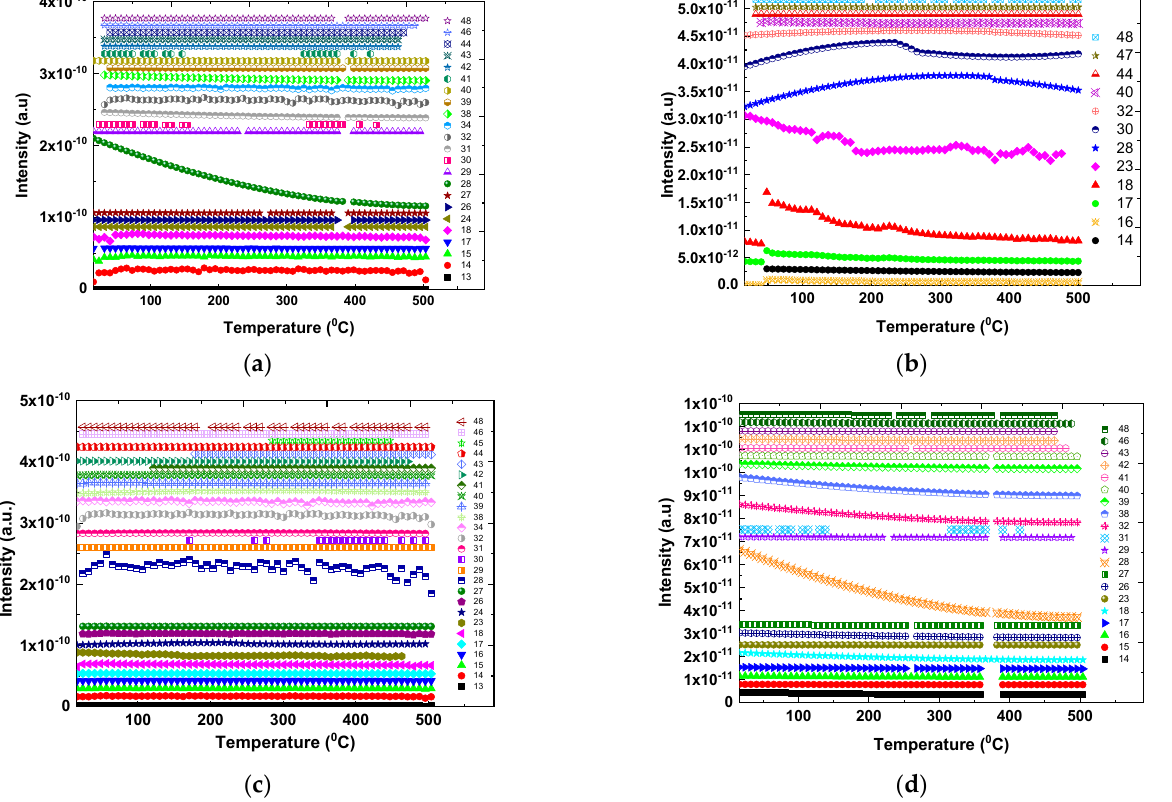
Figure 9. Temperature variation of the mass spectra obtained from thermal decomposition of the four samples: AZA in dark conditions ( a ), Na 2 S 2 O 3 ( b ), AZA after UV exposure ( c ) and the ST-reacted AZA after UV irradiation (AZA:ST 50 wt.%: 50 wt.% sample) ( d ). Table 3. Spectral peaks of the pyrolysis of the four samples and their key fragments.